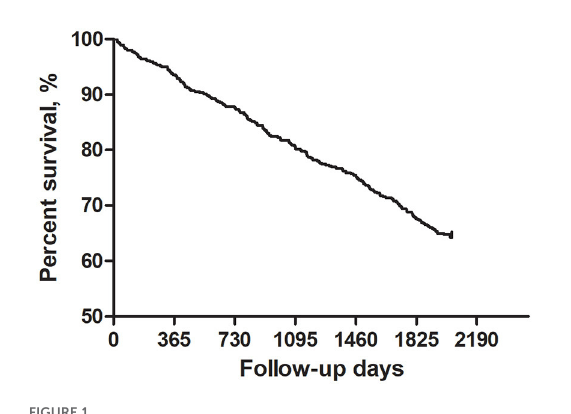
FIGURE1 Survival of patients with atrial fibrillation.